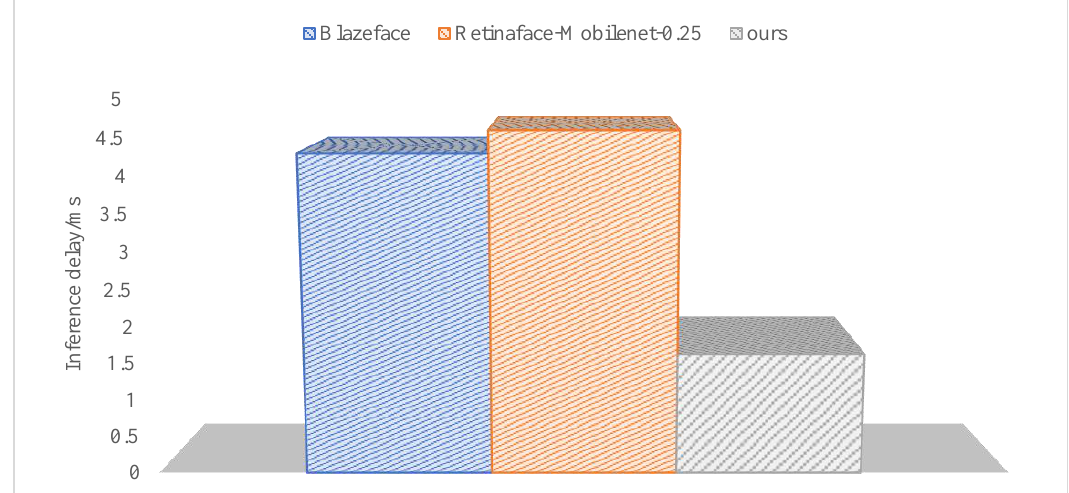
Figure 5. Comparison with advanced face detection models.